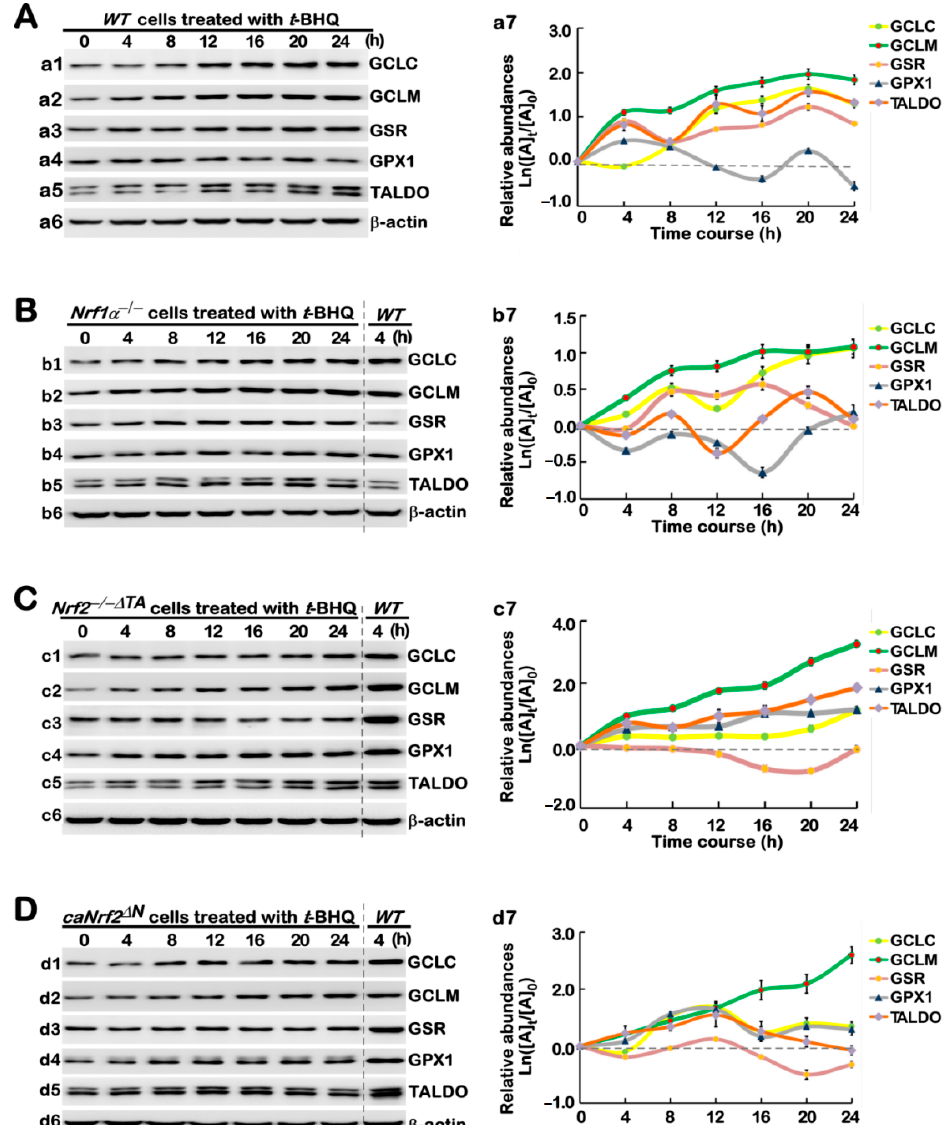
Figure 4. Long-term t BHQ-stimulated changes in the protein expression of antioxidant responsive genes. Different lines of WT ( A ), Nrf1 α − / − ( B ), Nrf2 − / −Δ TA ( C ), and caNrf2 Δ N ( D ) were treated with 50 μ M t BHQ or not for 0 to 24 h, before basal and stimulated abundances of those antioxidant cytoprotective proteins, e.g., GCLC ( a1, b1, c1, d1 ), GCLM ( a2, b2, c2, d2 ), GSR ( a3, b3, c3, d3 ), GPX1 ( a4, b4, c4, d4 ), and TALDO ( a5, b5, c5, d5 ), were determined by western blotting with the indicated antibodies. The intensity of relevant immunoblots representing different protein expression levels was also quantified by the Quantity One 4.5.2 software. The resulting data were then shown graphically (in right panels), after being calculated by a formula of Ln([A] t /[A] 0 ), in which [A] t indicated a fold change (mean ± SD) in each of those examined protein expression levels at different times relative to the corresponding controls measured at 0 h (i.e., [A] 0 ), which were representative of at least three independent experiments.